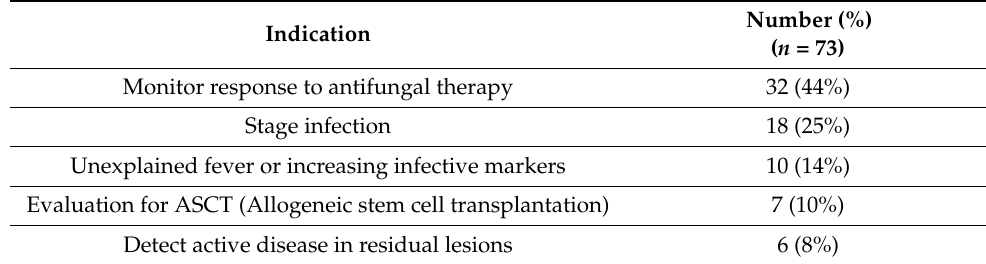
Table 2. Indication for the [ 18 F]FDG PET/CT